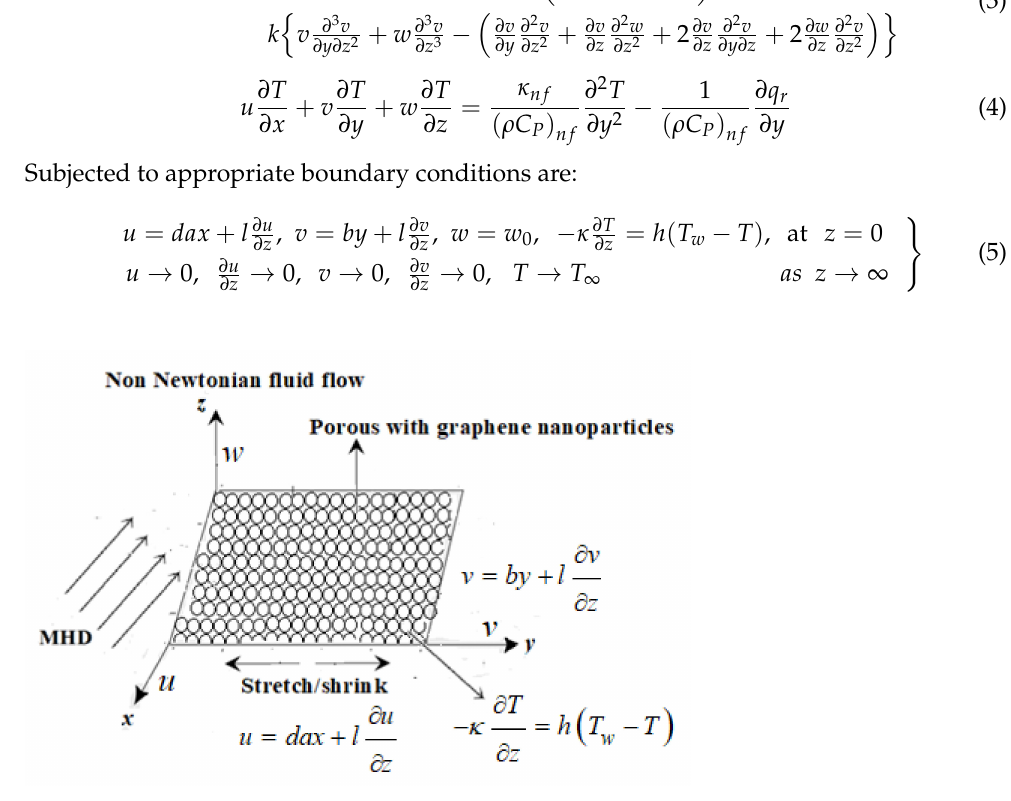
Figure 1. Physical diagram of three-dimensional fluid flow. Table 1. Thermophysical properties of base fluid and